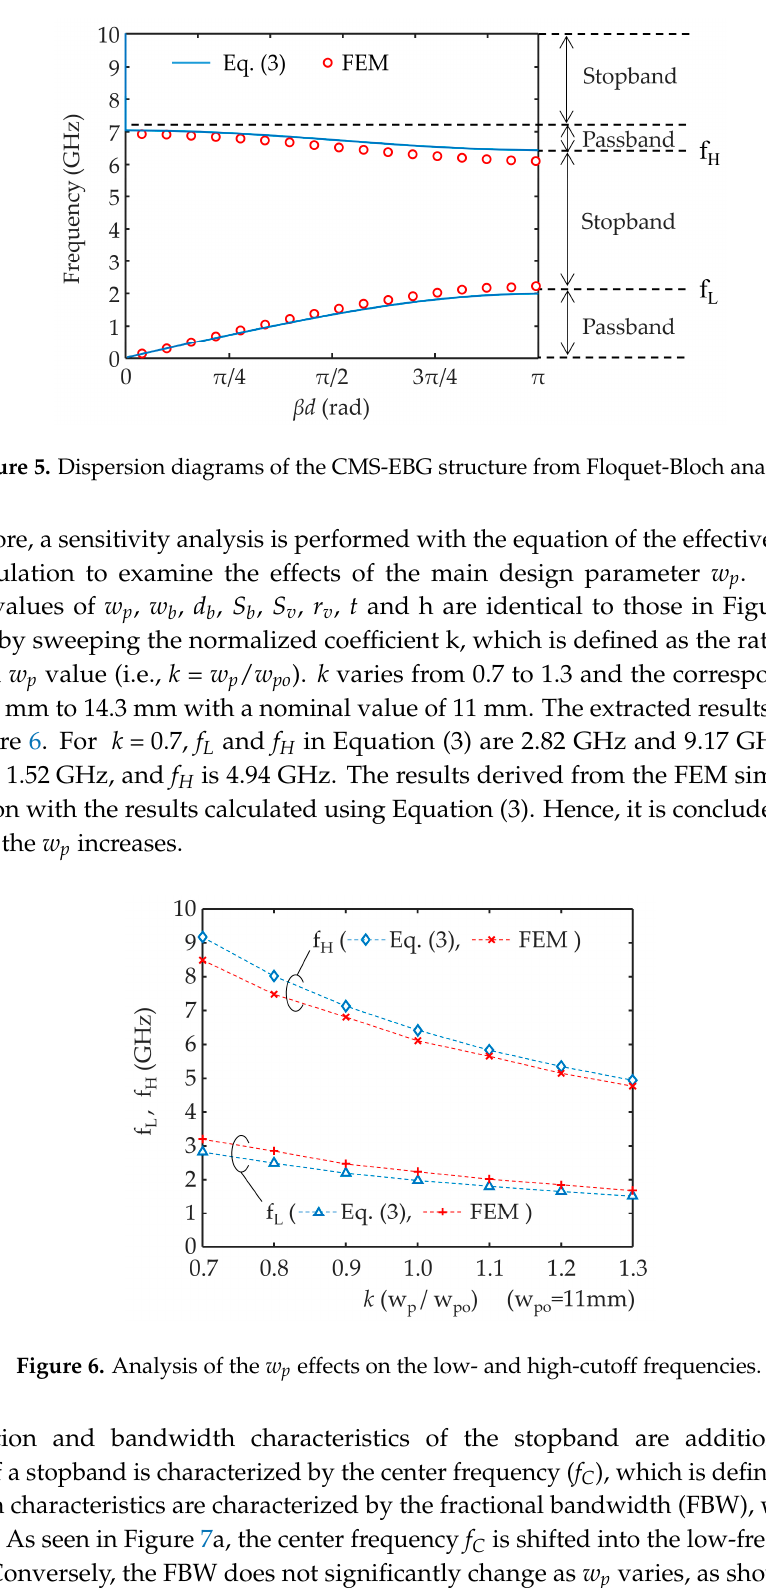
( a ) ( b ) Figure 7. Analysis of the w p effects on the ( a ) center frequency and ( b ) fractional bandwidth. 4. Results and Discussion To verify the CMS-EBG structure, a test vehicle is fabricated using a commercial MPCB manufacturing process. The MPCB process provides twelve metal layers from L1 to L12. L1 is dedicated to probe pads for the measurements. The other layers are used for the CMS-EBG structure as shown in Figure 8. Copper and FR-4 are used for the conductor and dielectric material, respectively. The relative permittivity of the FR-4 is 4.4, and the loss tangent is 0.03. The copper thickness is approximately 17 μ m. The distance between the layers (i.e., dielectric thickness) is 0.1 mm. The low-Z o patch, high-Z o patch, and ground plane are implemented by etching copper. A plated through hole (PTH) via is used in the MPCB process. The VCA branches and ground vias are made using the PTH vias. The MPCB process here is reliable, cost-effective, and easy to manufacture. Port 1 contains the signal terminal, which is connected to the high-Z o patch of UC (1,5) in L3 and the ground terminal, which is connected to the corresponding ground layers in L2 and L4. Port 2 consists of the signal terminal, which is connected to the high-Z o patch of UC (4,1) in L11. In addition, the ground terminal of Port 2 is connected to the corresponding ground layers in L10 and L12. The port configuration is equivalent to the ports in the Z o -lattice diagram in Figures 2a and 3. The top view of the CMS-EBG structure fabricated by the MPCB process is shown in Figure 8. The geometrical parameters are described in Figure 4 of Section 3. The values of the design parameters w p , w b , d b , S b , S v , r v , t and h are 11, 1, 1, 5, 1, 0.2, 0.017, and 0.1 mm, respectively, which are equivalent to the values in the Floquet-Bloch analysis. The unit cell length is 12 mm. The distance between port 1 and port 2 is only 4 mm, which is less than the unit cell length. In addition, sixteen